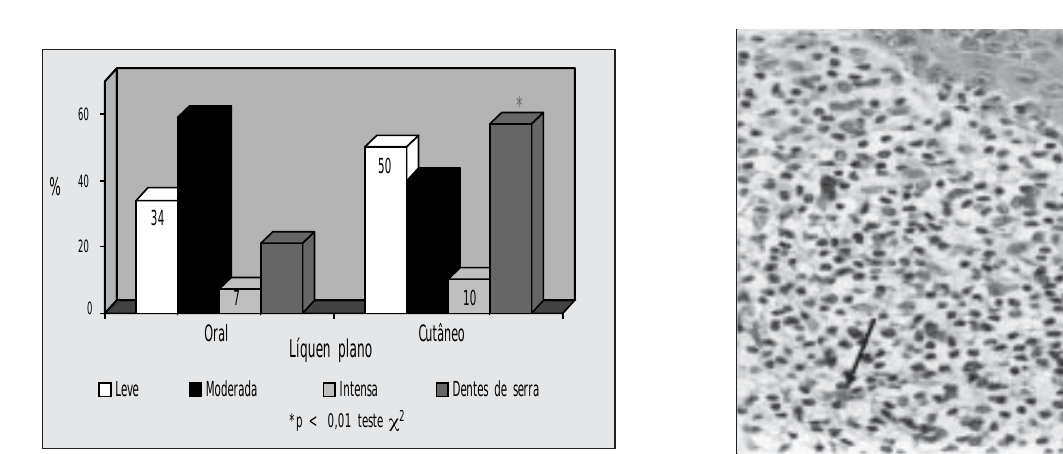
Figura 6 – Avaliação da camada córnea das 23 biópsias de líquen plano oral (áreas normalmente